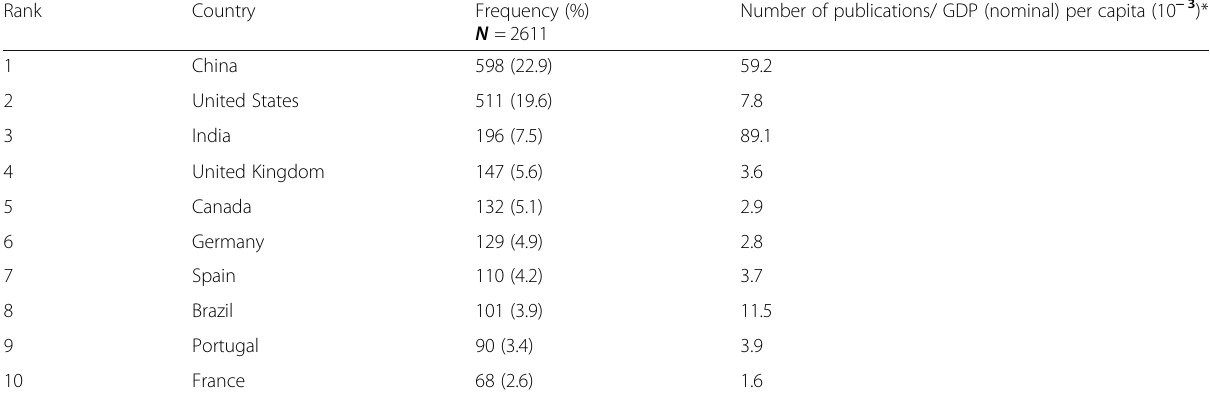
Table 2 Top ten active countries in AMR in the environment research (2000 – 2019) Rank Country